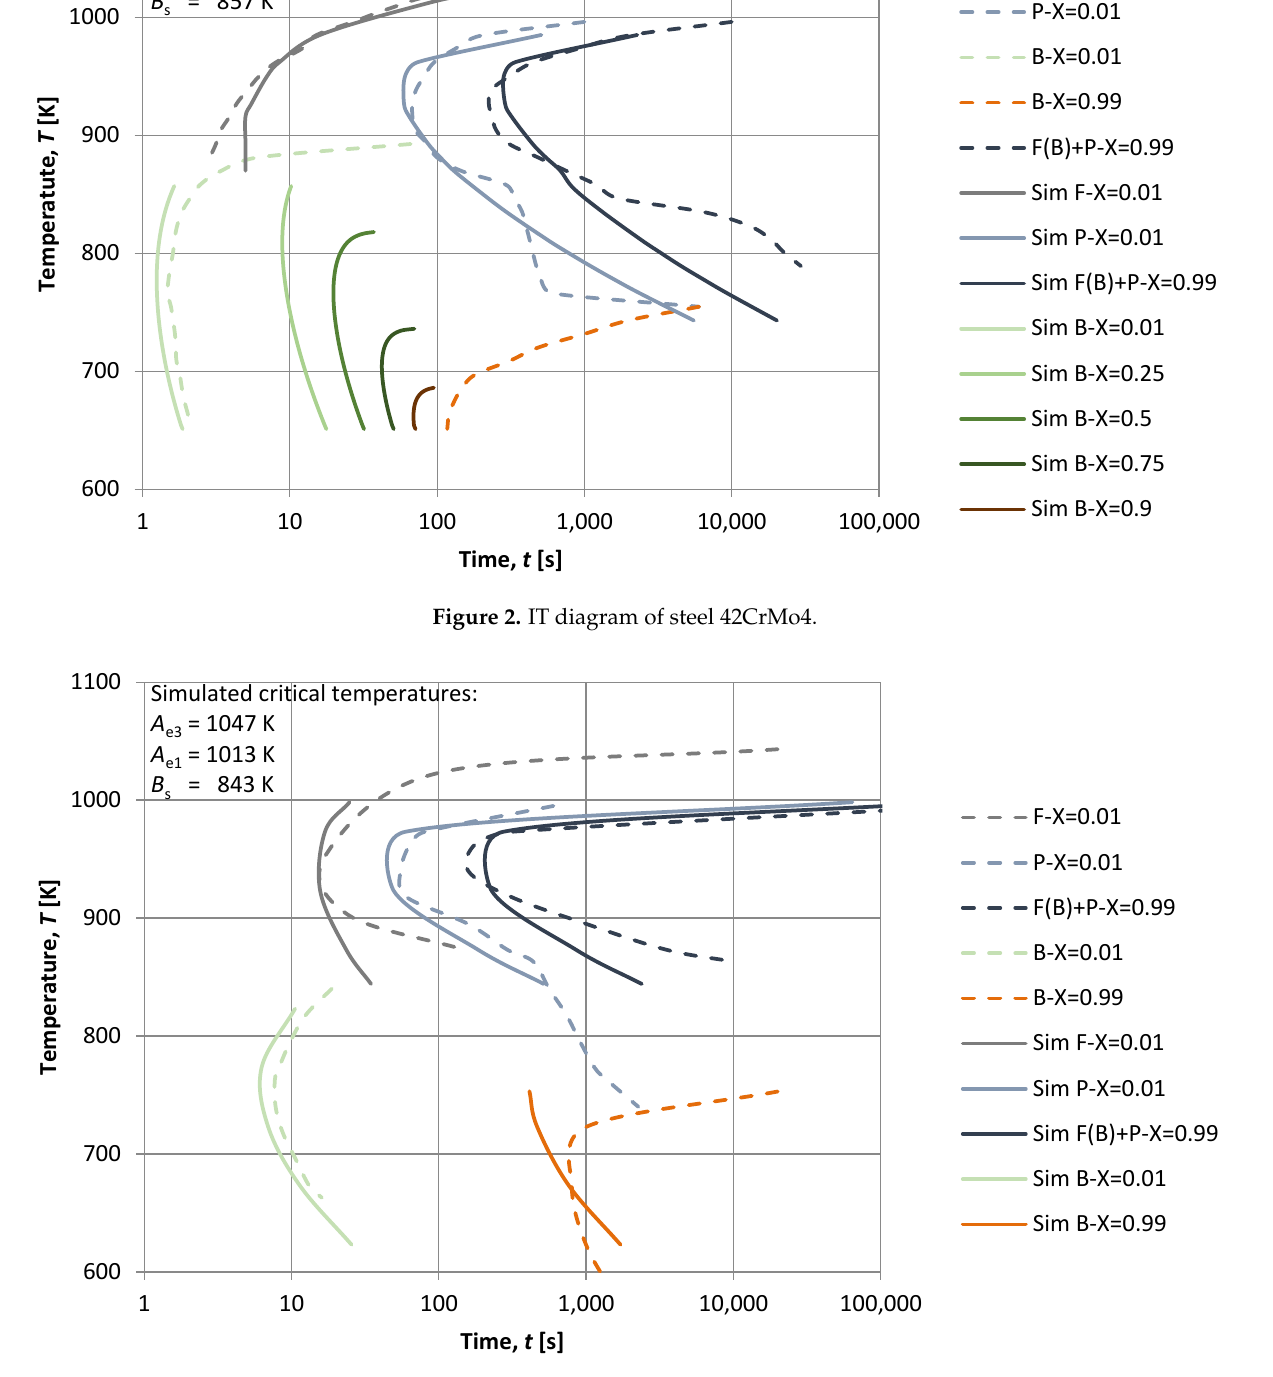
Figure 3. IT diagram of steel 36Cr6.